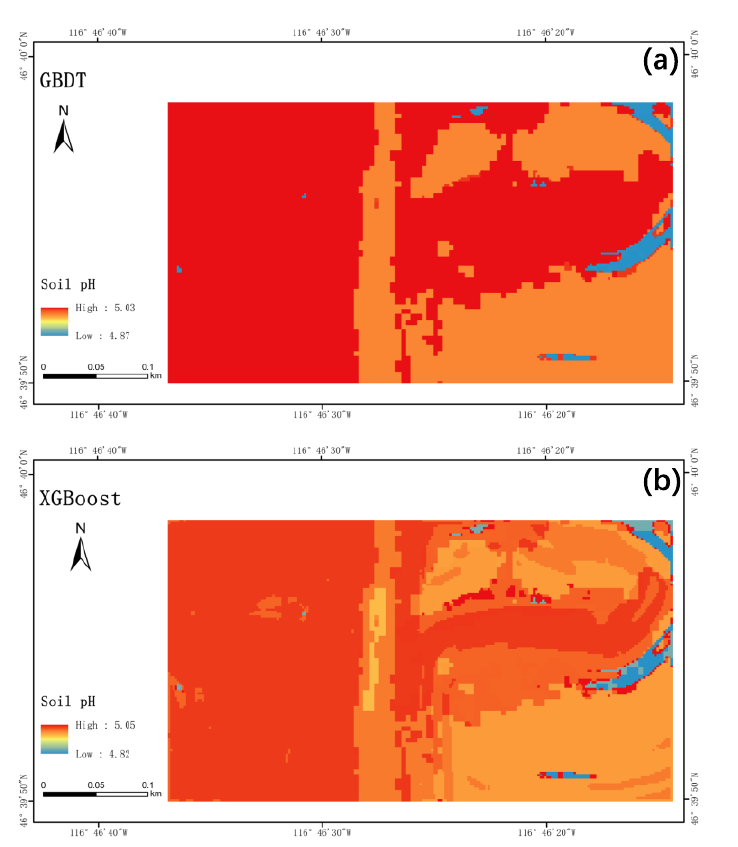
Figure 6. Maps for predicting soil pH in the Palouse region based on SVM-RFE feature selection with XGBoost and GBDT models. ( a ) GBDT: gradient boosting decision tree; ( b ) XGBoost: extreme gradient boosting.